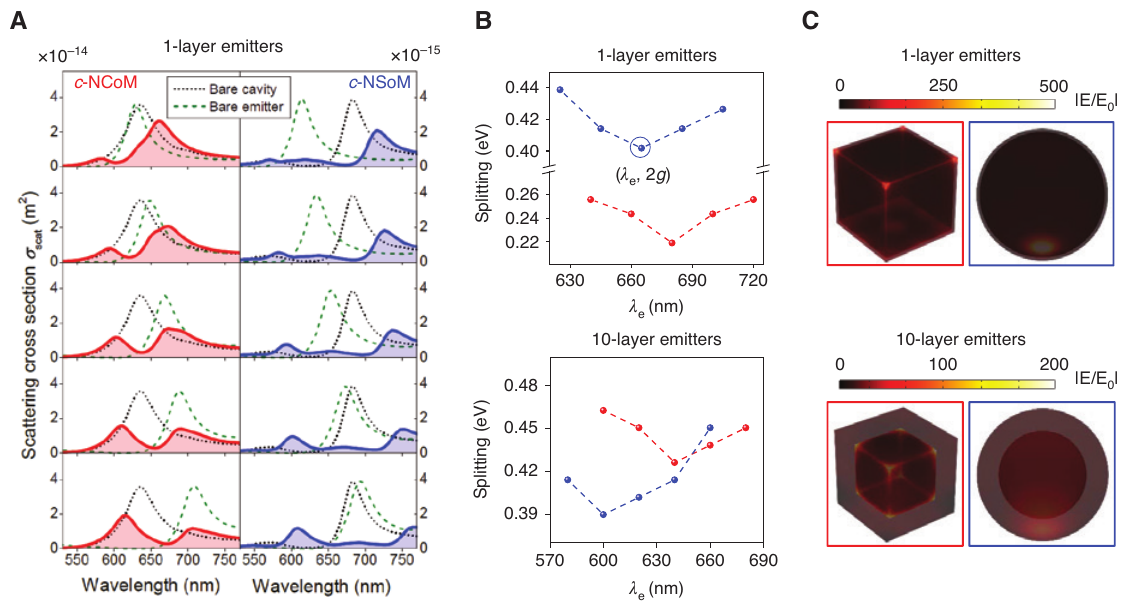
Figure 2: Strong coupling simulations of the plexcitonic system. (A) Simulated strong coupling between fixed cavities and emitters (1 nm thick, single layer), with emitter resonance λ swept from 640 to e 720 nm for c -NCoM (left) and from 625 to 705 nm for c -NSoM (right). Dashed black/green lines represent the responses from bare cavities/ emitters. (B) Rabi splittings extracted from the scattering cross-section spectra in (A) across different emitter wavelengths. The coupling rate g and the corresponding emitter wavelength λ or energy ω can be read at the minimum Rabi splitting. Two cases of 1- and 10-layer emitters e e are illustrated. (C) Near-field distributions in the 1-layer emitters (top) or 10-layer emitters (bottom) for the antenna mode of c -NCoM and gap mode of c -NSoM, respectively. In all cases, nanoparticles have the same size of 40 nm. Each emitter layer is assumed to be 1 nm thick with fixed oscillation strength f = 0.27, e.g. methylene blue